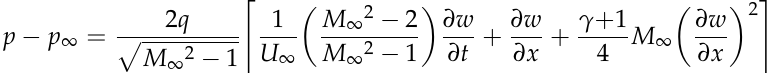
U ∞ is the velocity of freestream and q = ρ ∞ U ∞ 2 /2 is dynamic